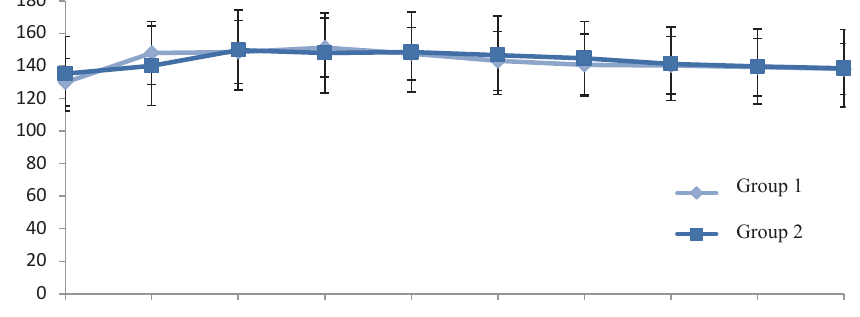
Figure 3. The heart rate of patients during the study in groups 1 (ropivacaine) and 2 (lidocaine with